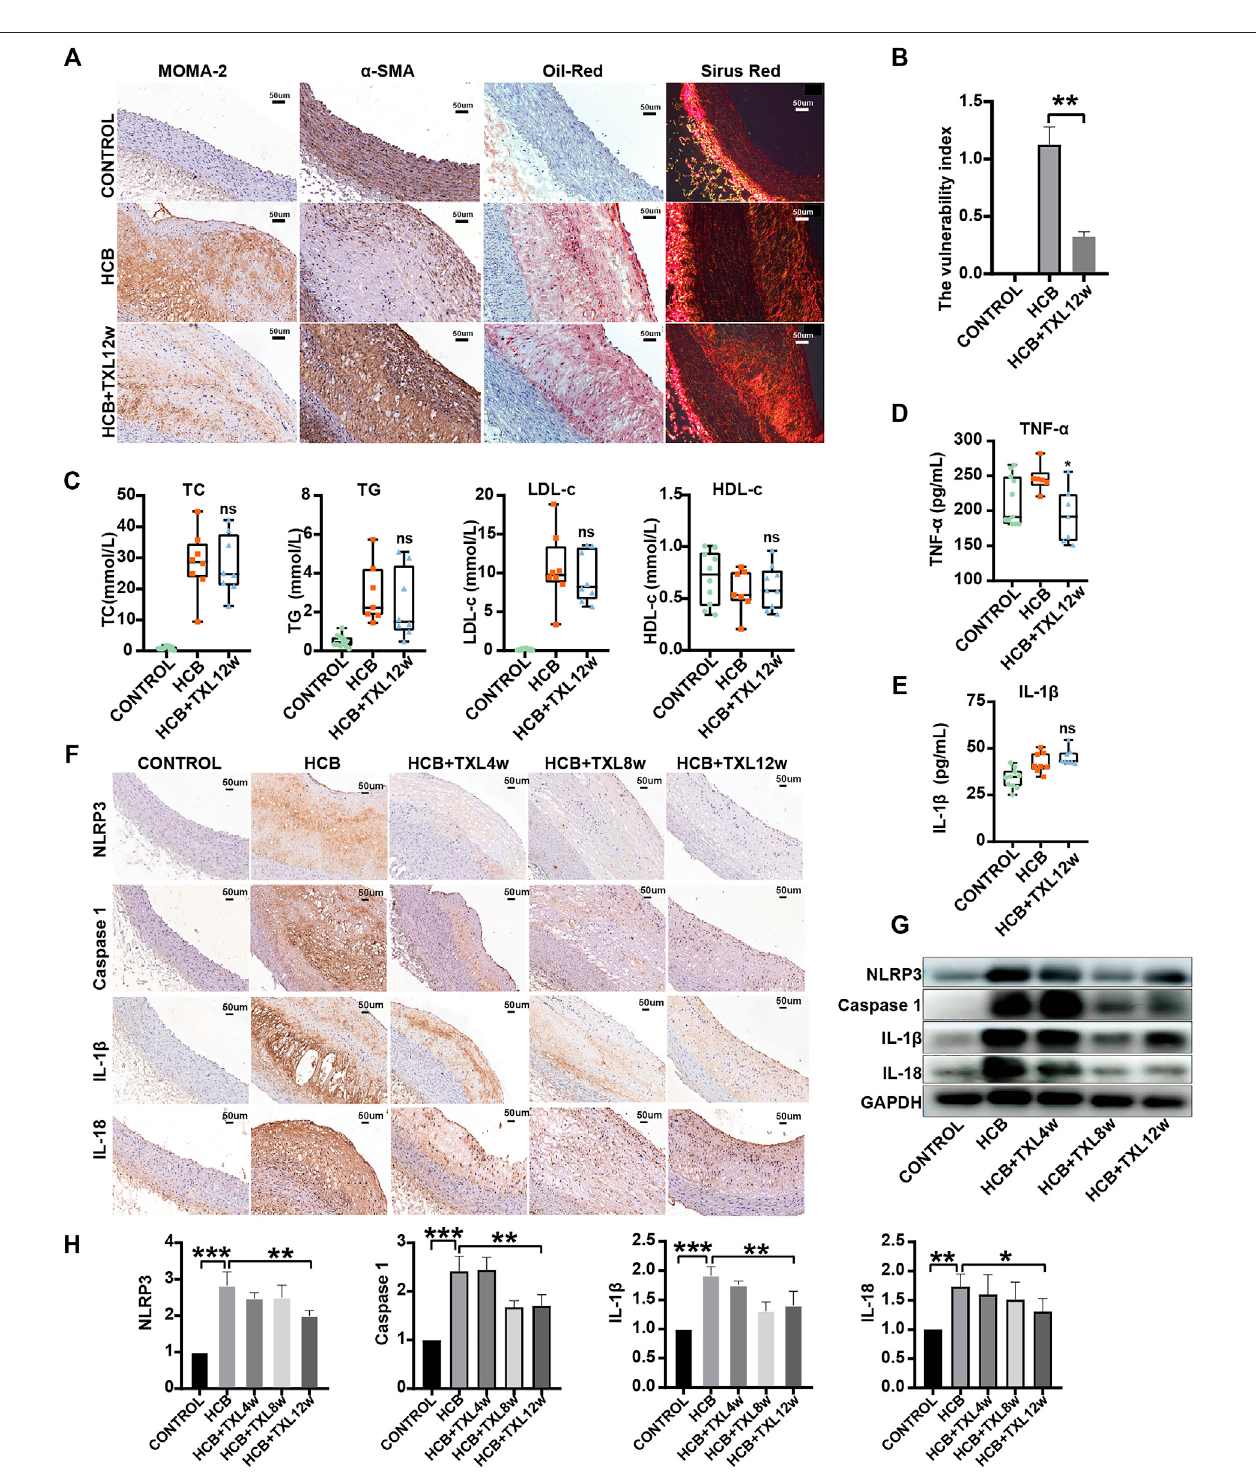
FIGURE 2 | Tongxinluo improved the stability of HCB-induced plaques and alleviated in fl ammation through non-lipid-dependent pathways in rabbits. CONTROL: normaldiet(n=12);HCB:highcholesteroldietandballooninjury(n=8);HCB+TXL4w:HCBandtreatedwithTXLfor4weeks(n=7).HCB+TXL8w:HCBandtreated with TXL for 8 weeks (n = 8). HCB + TXL 12w: HCB and treated with TXL for 12 weeks (n = 10) (A) Plaque ’ s stability test results. Oil red O staining was applied to show lipid in abdominal aorta. Sirius red staining was used to detect collagen fi bers. Abdominal aorta sections were stained for macrophages (MOMA-2) or vascular smooth muscle cells ( α -SMA). bar = 50 μ m (B) Plaque vulnerability index statistics. Data are shown as the mean ± S.E.M. **: p < 0.01. (C,D,E) The changes of Blood